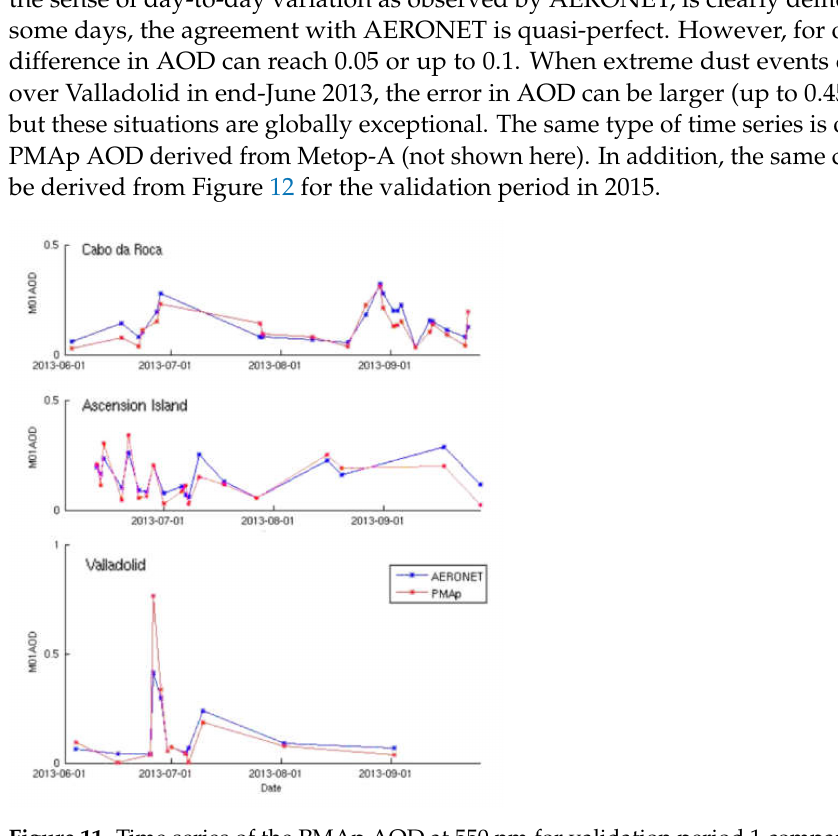
Figure 11. Time series of the PMAp AOD at 550 nm for validation period 1 compared to the AOD retrieved from Metop-B and for 3 AERONET sites: Cabo da Roca, Ascension Island, and